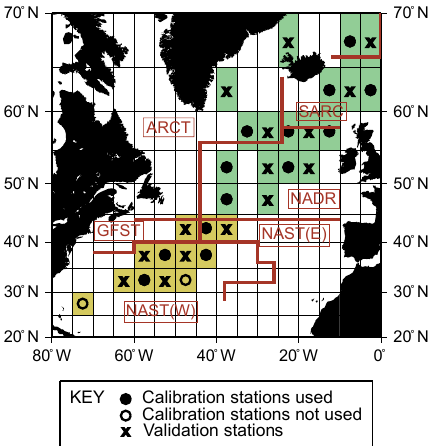
Figure 6. Geographic extent of the two sub-domains giving the op- timal calibration in the split-domain calibration study of Hemmings et al. (2004), shown here in yellow and green. Also shown are the distributions of the sites used from the calibration set to obtain the parameter vectors for each sub-domain and the sites used for cross- validation. Biogeochemical provinces defined by Longhurst (1998) are shown for reference. ARCT: Atlantic Arctic Province; SARC: